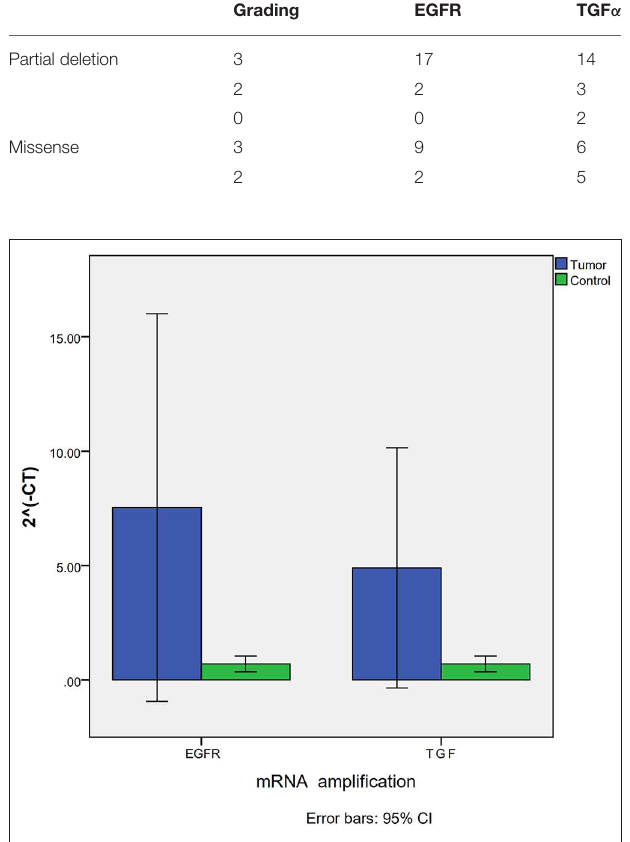
FIGURE 2 | Expression of EGFR and TGF α mRNA assessed by RT-PCR showing significant upregulation for both EGFR and TGF α transcripts in VHL-related